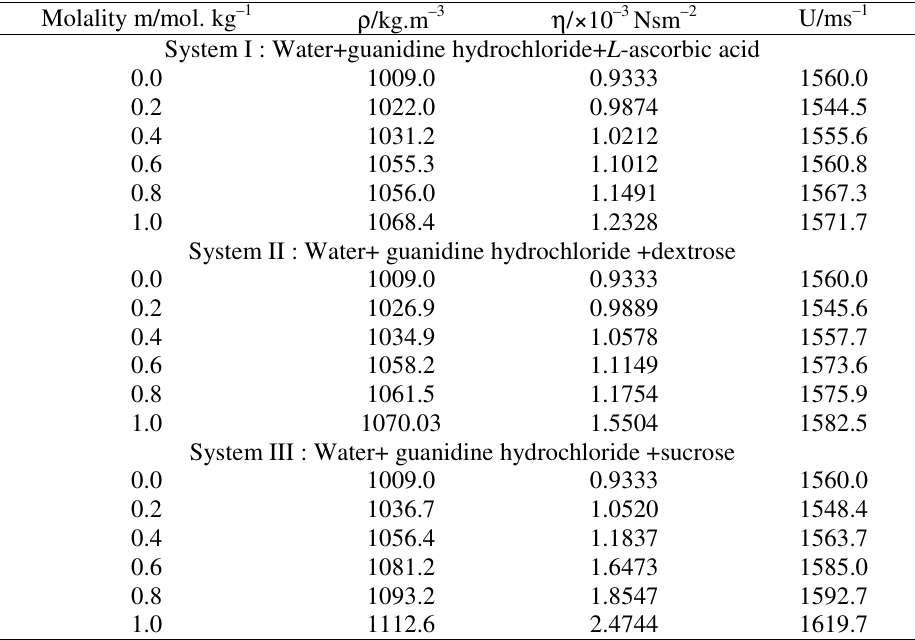
Table 1. Values of density ( ρ ), viscosity ( η ) and ultrasonic velocity (U) of L -ascorbic acid, dextrose and sucrose in aqueous guanidine hydrochloride solution at 298.15 K Molality m/mol. kg